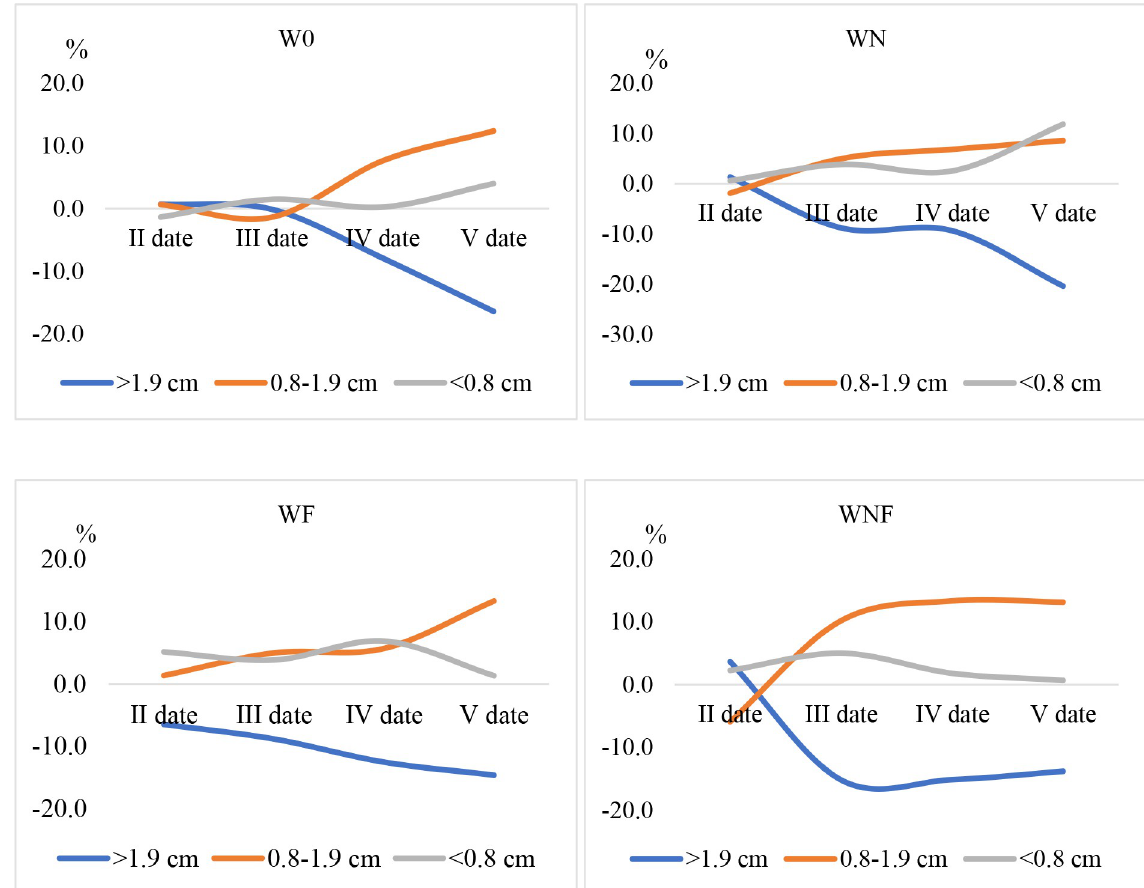
Fig 4. The structure of the compost biomass changes over the composting process with various additives to the compost. Percentage changes in the beginning of the biomass structure process (in different composting dates and variants).